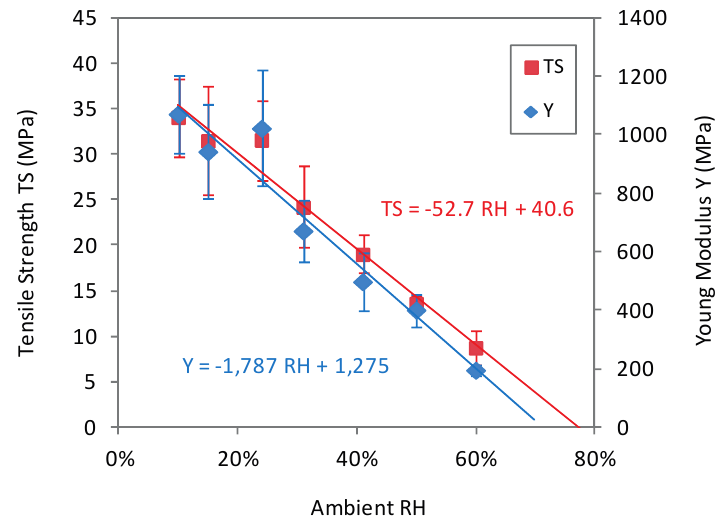
Figure 1. Tensile properties of ~0.04 mm CaCas/Gly films measured in transient stress-strain mode with the DMA chamber opened to ambient conditions (~20 °C and varying RH depending on the day). Samples were stored at 60% RH for 5–12 days before testing. At the extension rate of 1 N/min, CaCas/Gly films appeared strong and stiff and highly sensitive to ambient moisture. TS and Y decreased linearly when RH increased and ambient moisture plasticized the films, comparable to the results of Bonnaillie et al. [3]. The elongation at break ( D ) was low and varied from D ~ 8% at 10% RH to D ~ 27% at 60% RH. Linear extrapolation of TS and Y to zero suggests the existence of a point of null strength for the films between 70% and 80% RH, where the protein network becomes “fluid”, similarly to a heat-induced melting